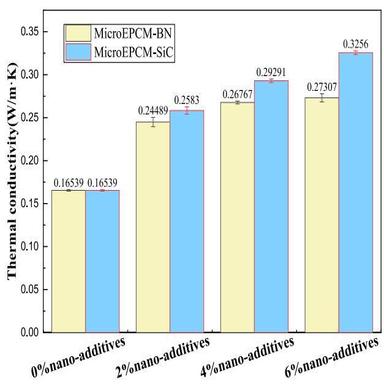
Thermal conductivity diagram of MicroEPCM with nano-additives.